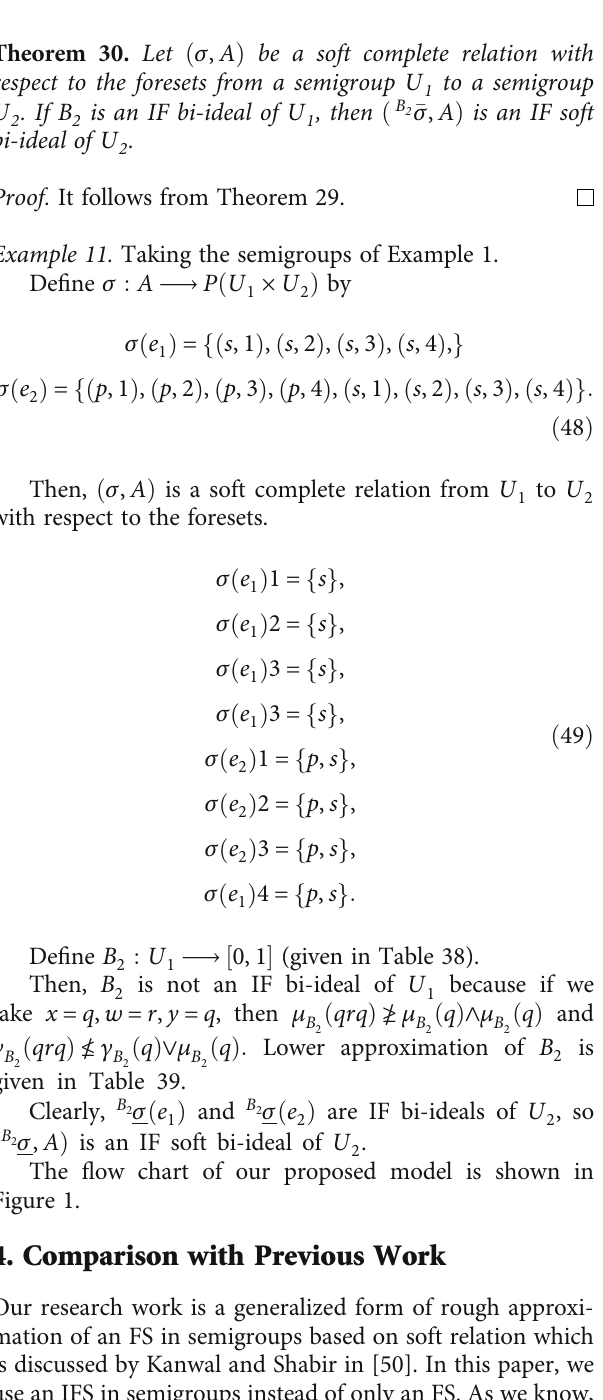
Table 34: Intuitionistic fuzzy set B